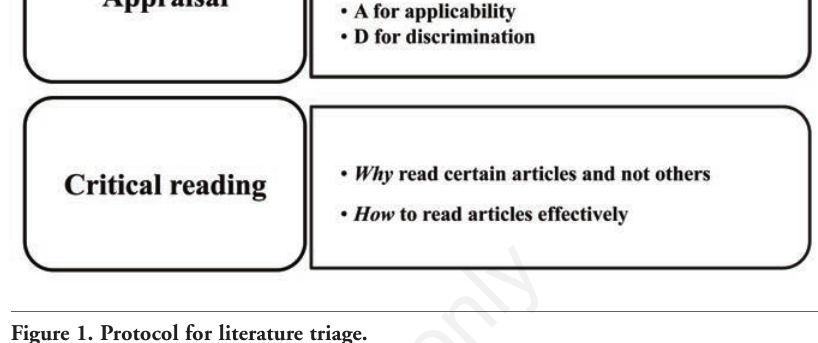
Figure 1. Protocol for literature